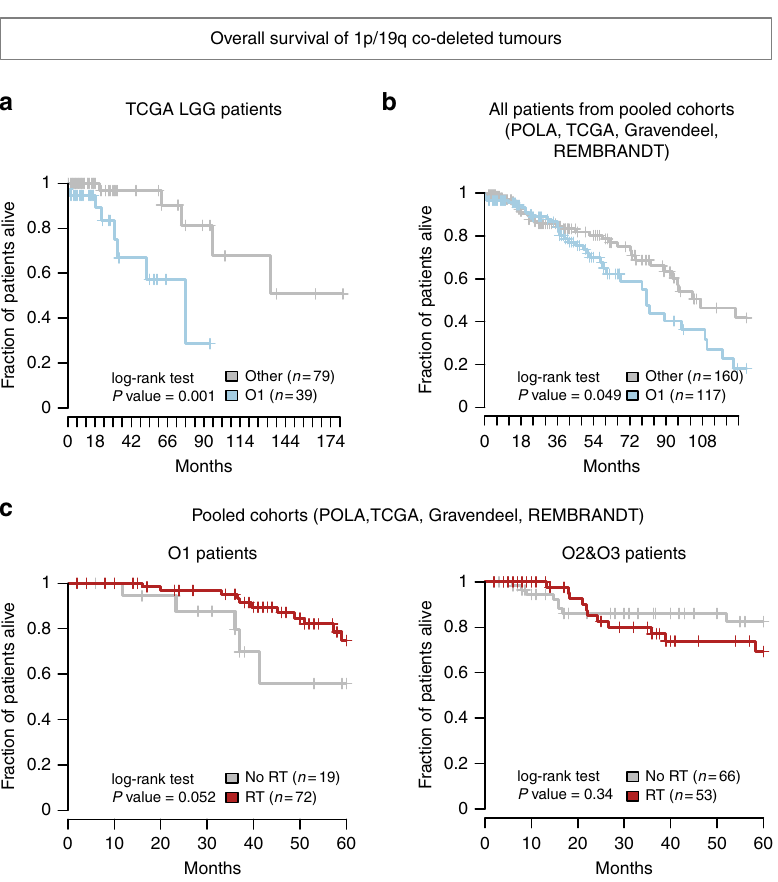
Figure 7 | Overall survival of 1p/19q co-deleted tumours ( a ) Overall survival of TCGA patients with 1p/19q co-deleted tumours according to O1 subtype membership. We used the available clinical data from 118 patients with co-deleted tumours (59 with grade III tumours and 59 with grade II tumours). ( b ) Overall survival of all 278 patients with 1p/19q co-deleted tumours after pooling patients with available clinical data from TCGA ( n ¼ 118 patients), POLA ( n ¼ 80 patients), Gravendeel ( n ¼ 42 patients) and REMBRANDT ( n ¼ 37 patients) cohorts. ( c ) Overall survival of O1, and other O2 or O3 patients who did or did not receive radiotherapy as initial treatment after surgery. We used data from 222 patients with 1p/19q co-deleted tumours that were pooled from the four cohorts: POLA ( n ¼ 75 patients), TCGA ( n ¼ 66 patients), REMBRANDT ( n ¼ 49 patients) and Gravendeel ( n ¼ 32 patients). Patients were included if their treatment and survival data were available and if they had not deceased within the first 3months after diagnosis so that they could have effectively received radiotherapy. For each subgroup of patients (with O1, O2 or O3 tumours) we compared the five-year survival of patients treated with an initial radiotherapy (RT, red curves)—combined or not with chemotherapy—against patients who had not received initial radiotherapy and were managed with initial follow-up or with chemotherapy alone (No RT, grey curves). NATURE COMMUNICATIONS|7:11263|DOI: